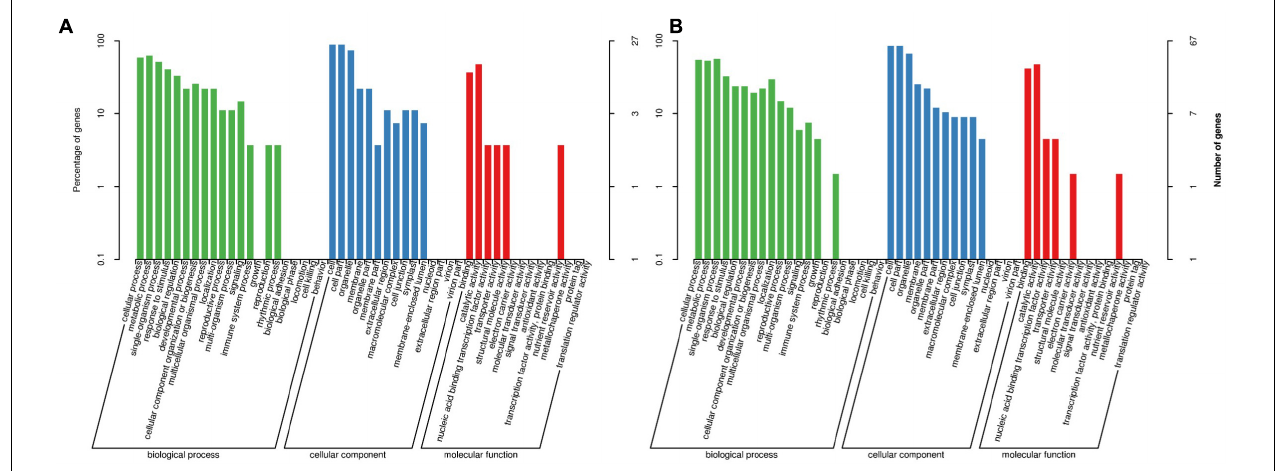
FIGURE 2 | Gene Ontology (GO) terms associated with two classifications of differentially expressed genes (DEGs). (A) Thirty-three stable DEGs representing same or similar expression trends in both environments. (B) Ninety-six environment-specific DEGs showing different expression trends from Xindu to Ma’erkang. X -axis shows GO categories and subclasses of DEGs; y -axis shows number or percentage of annotated